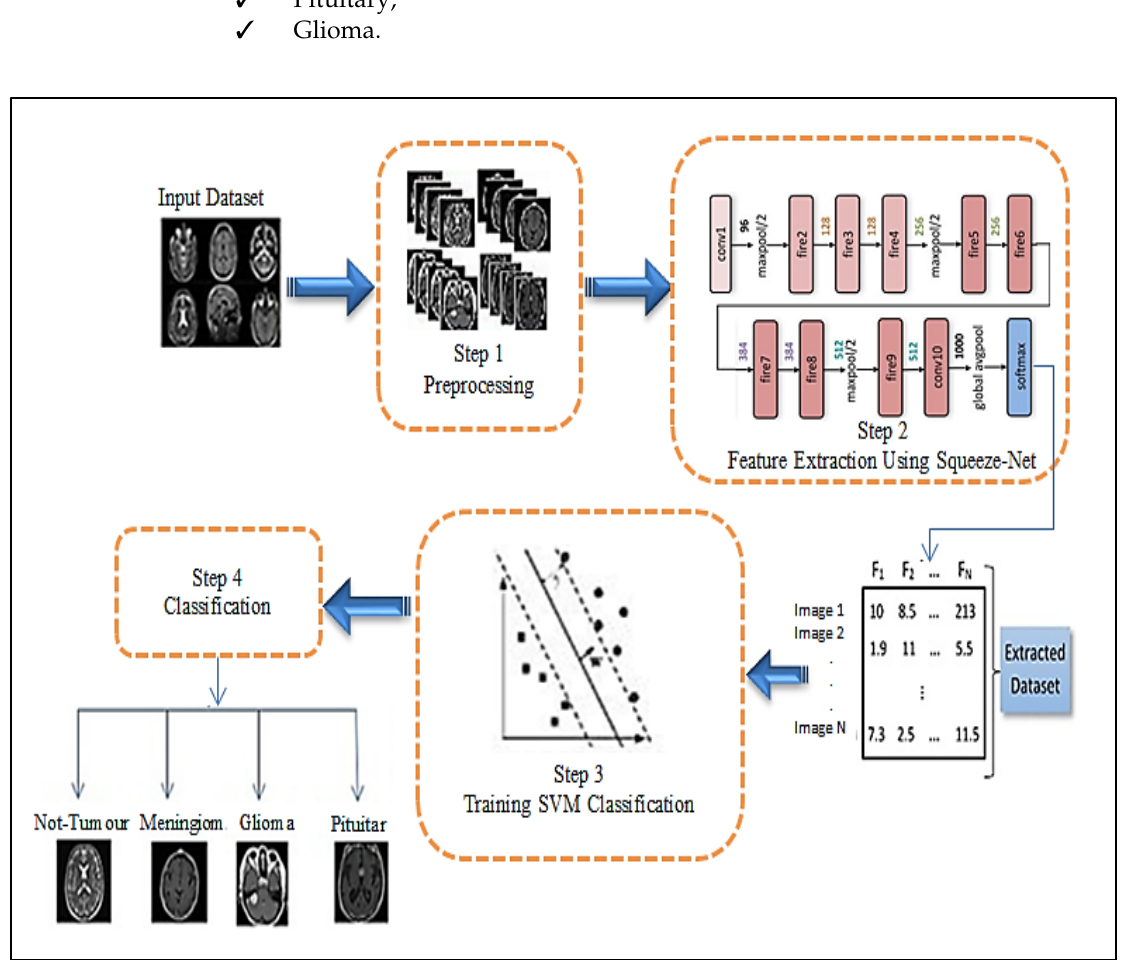
Figure 4. Structure of the SN-SVM model.